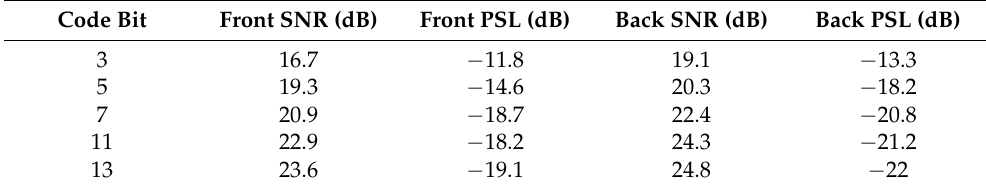
Table 2. The SNR and PSL of Barker codes of different lengths at 30 kHz from the front and back pipe ends.